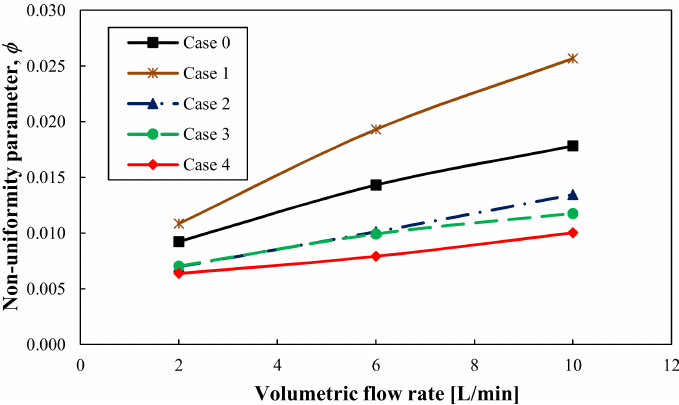
Figure 13. Comparison of non-uniformity parameter for studied cases at three different volumetric flow